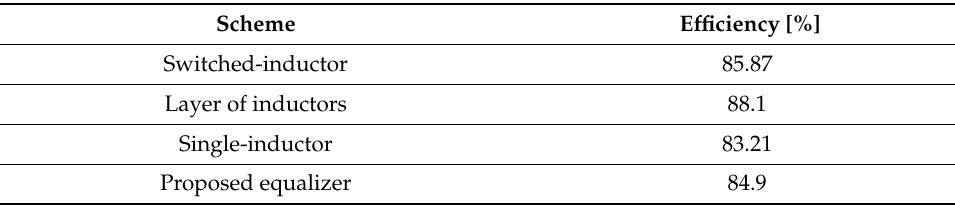
Table 1. Summary of the values of efficiency obtained for each